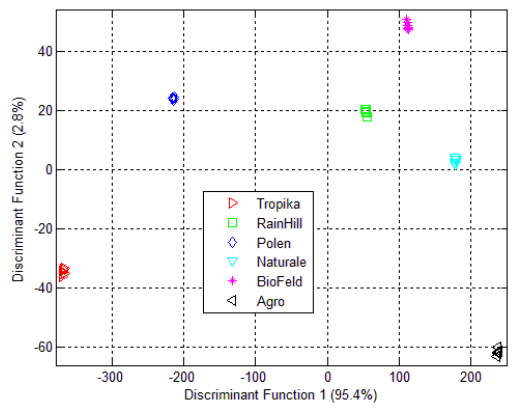
Figure 9. LDA plot using data fusion technique (based on tea infusion assessment of e-nose and